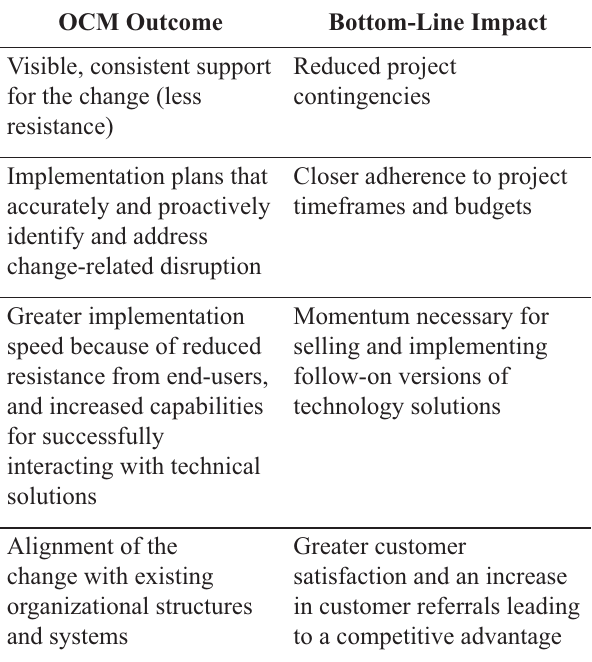
Table 2. Outcomes of Effective Organizational